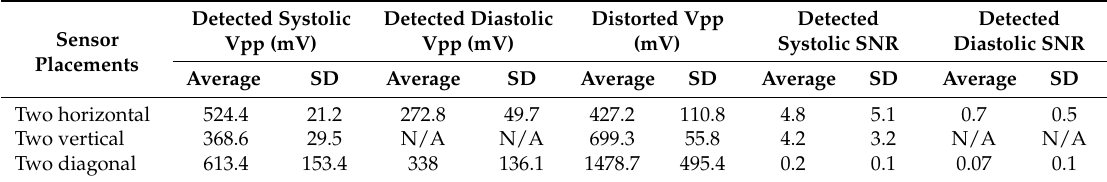
Table 2. Signal measurements of using two sensors with SUBTRACTOR on walking